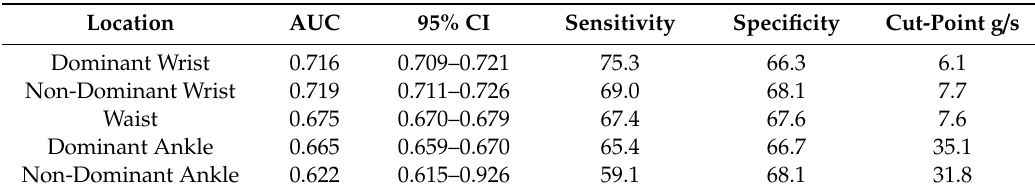
Table 2. Area under the curve (AUC), sensitivity (%) and specificity (%) and resultant cut-points for each GENEActiv monitor with FMS